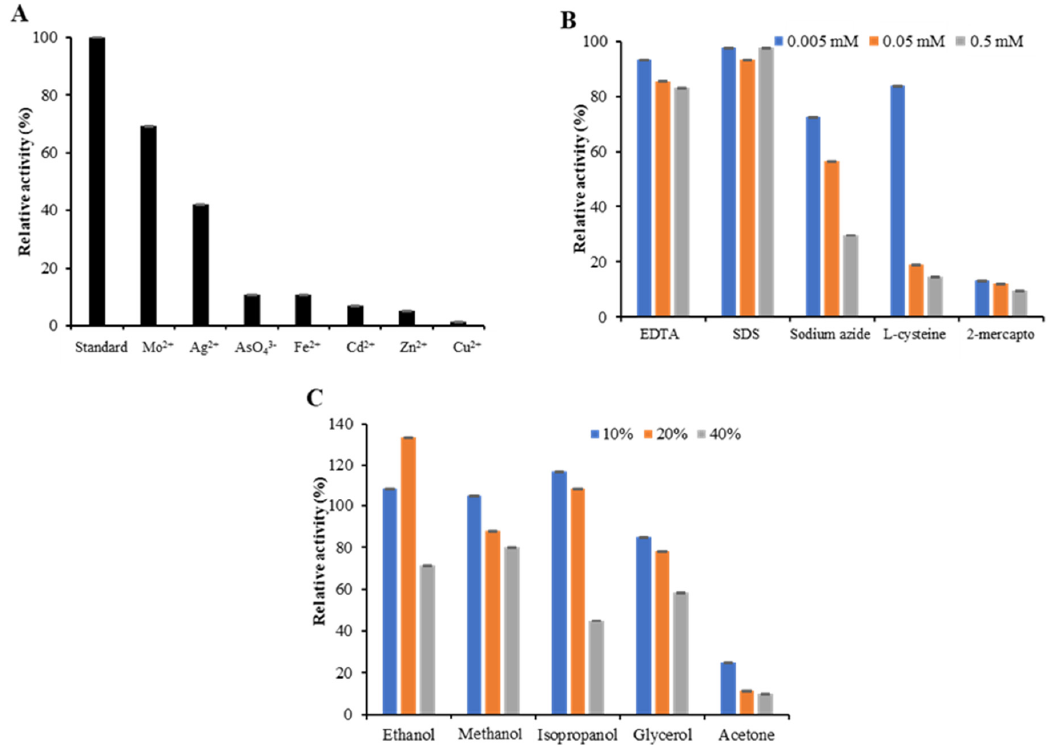
Figure 3. Effect of metal ions, inhibitors, and solvents on Sl Lac2 activity. ( A ) Effects of various metal ions ions (Mo 2 + , Ag 2 + , AsO 43 − , Fe 2 + , Cd 2 + , Zn 2 + , or Cu 2 + ) at 10 mM on the purified recombinant enzyme. (Mo 2+ , Ag 2+ , AsO 43 − , Fe 2+ , Cd 2+ , Zn 2+ , or Cu 2+ ) at 10 mM on the purified recombinant enzyme. ( B ) Effect of ( B ) E ff ect of various inhibitors (EDTA, SDS, 2-mercaptoethanol, l -cysteine, and sodium azide) on various inhibitors (EDTA, SDS, 2-mercaptoethanol, L -cysteine, and sodium azide) on Sl Lac2 activity at Sl Lac2 activity at di ff erent concentrations (0.5, 0.05 and 0.005 mM). ( C ) E ff ect of solvents (ethanol, methanol, isopropanol, glycerol, and acetone) at di ff erent concentrations (10, 20, and 40% vol / vol) on Sl Lac2